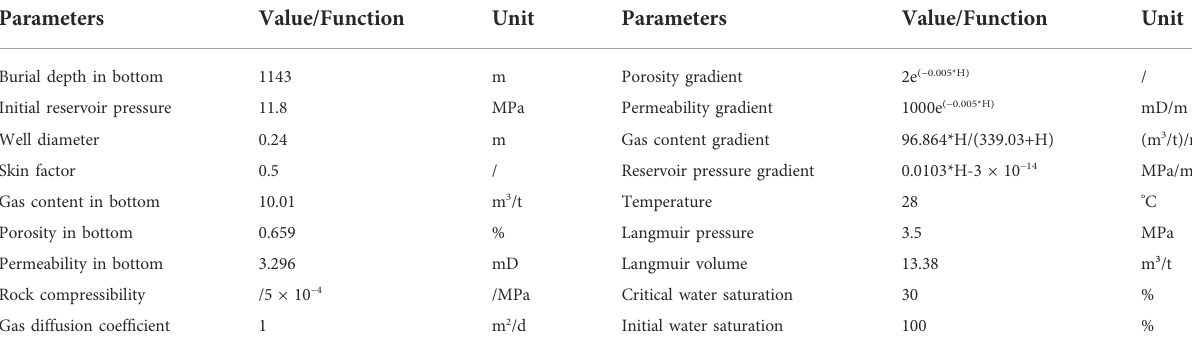
TABLE 1 Parameters of the simulation using the ASIM and ISIM